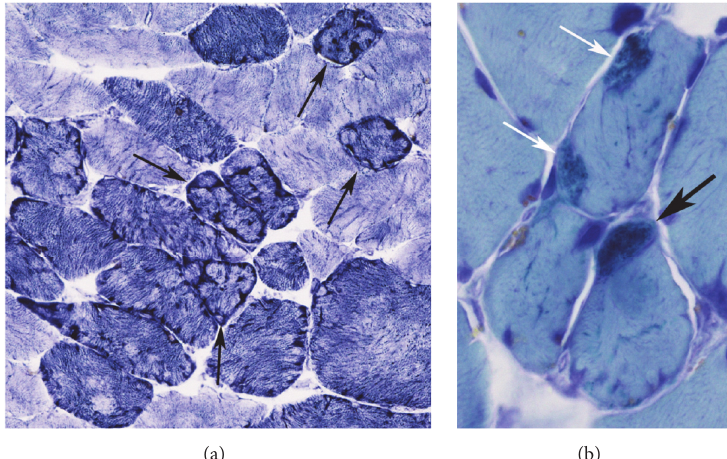
Figure 1: Pathologic findings in quadriceps muscle biopsy. (a) NADH stain. Chronic myopathic changes with fiber size variation and myofibrillar alterations, including many lobulated fibers (arrows). (b) G¨om¨ori trichrome stain. Many dark staining nemaline rods are seen in a highly atrophic fiber (black arrow) and aggregated beneath the sarcolemma (white arrows) and scattered in sarcoplasm in these adjacent myofibers.